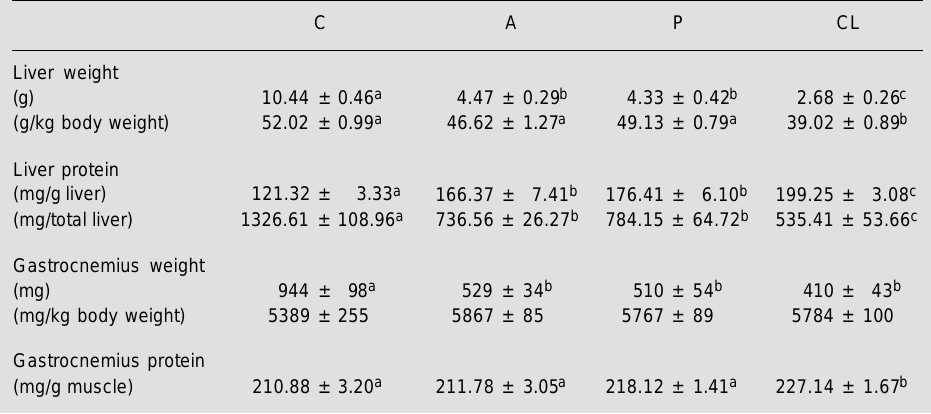
Table 3 - Effect of clenbuterol (CL) on liver and gastrocnemius weight and protein content. Results are reported as means ± SEM for 6 animals per group. Group C: Normally fed control rats; group A: low-protein with free access to food; group P: pair-fed with group CL; group CL: low-protein diet + Cl for 2 weeks. Values on the same row not sharing a common superscript are significantly different (ANOVA followed by Fisher’s least-significant-difference